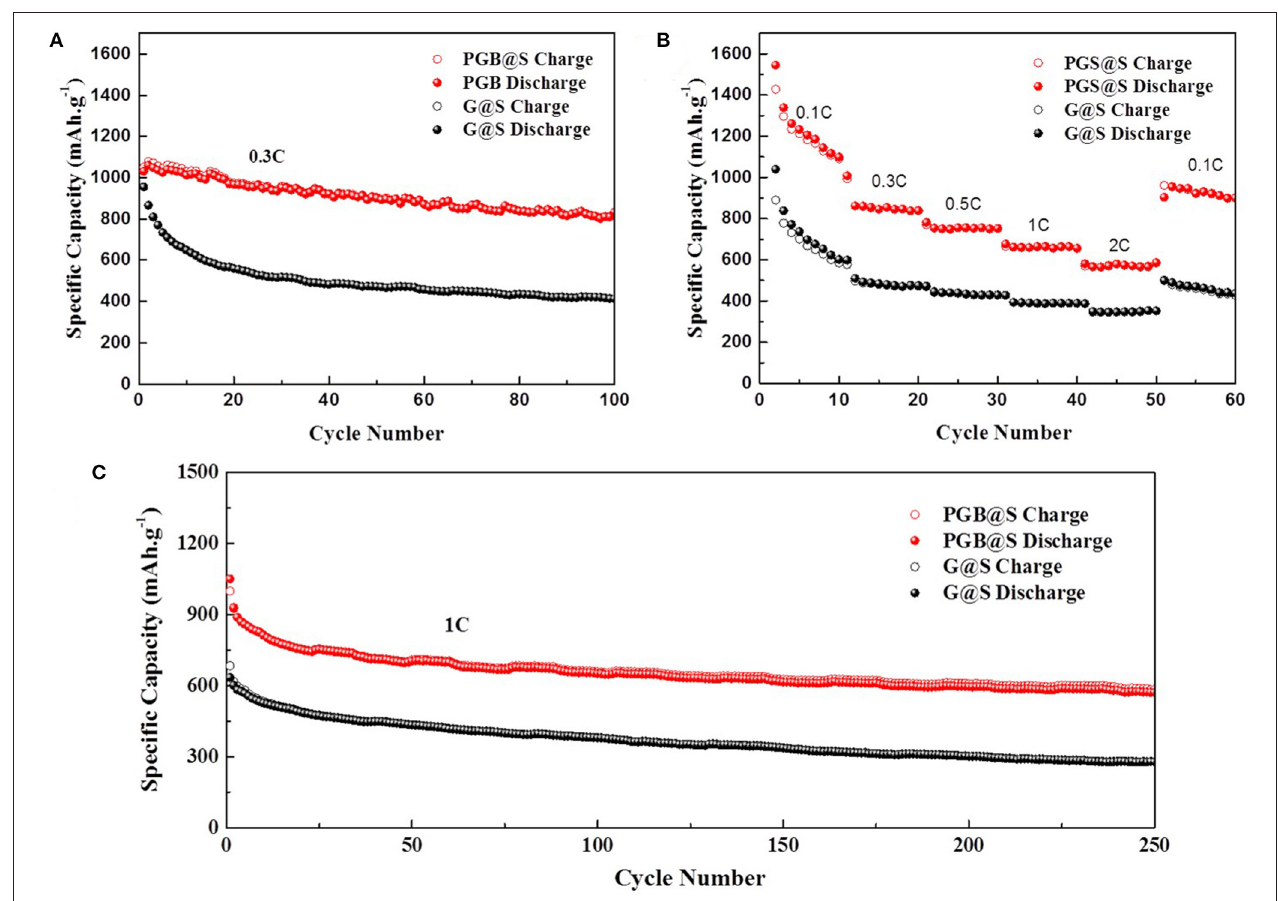
FIGURE 4 | (A) Cycling performances at 0.3C, (B) rate capacities, and (C) cycling performance at 1C of PGBs@S and G@S